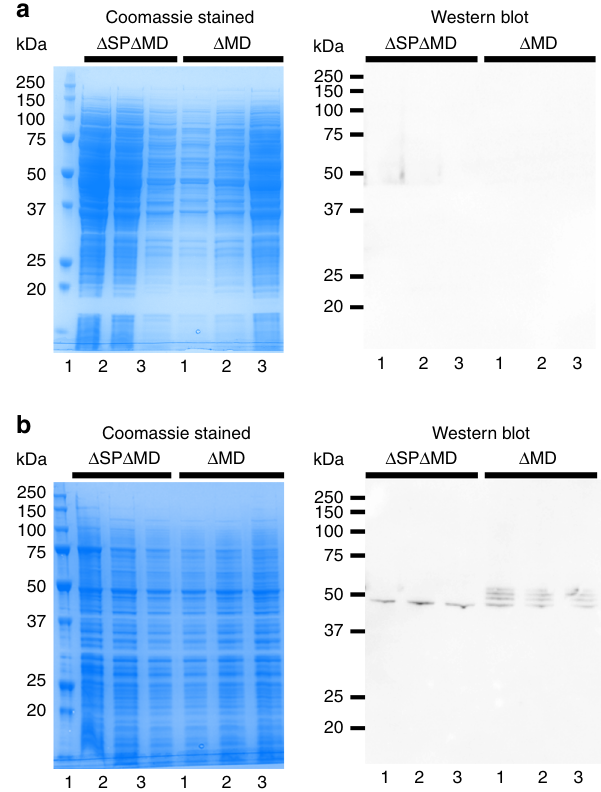
Fig. 9 Heterologous expression of truncated DcUGT2 forms in yeast. Three individual S. cerevisiae transformants were cultured for each Strep-tagged truncated DcUGT2 construct, Δ SP-DcUGT2 Δ MD-Strep and DcUGT2 Δ MD- Strep . After galactose-induced heterologous protein expression, microsomal and soluble proteins were isolated and separated on an SDS gel followed by either Coomassie staining or western blotting using an anti-Strep antibody.